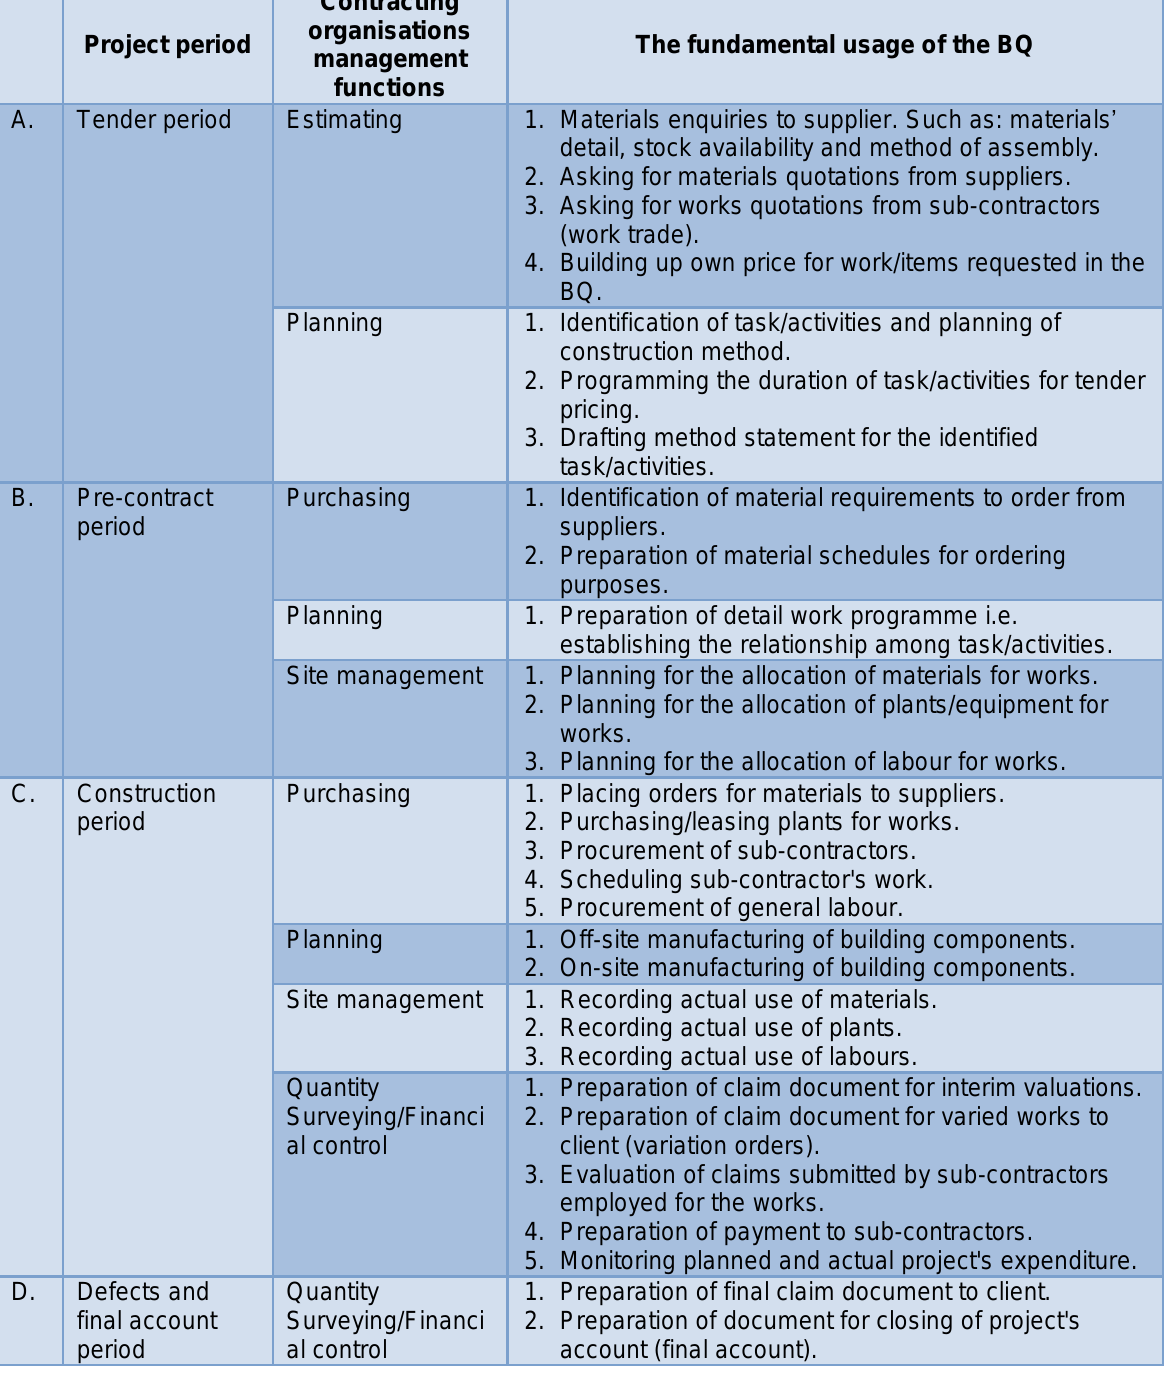
Table 6: The fundamental usage of the BQ by the contracting organisations – final outcome Source: adapted from the collation of studies by Smith and Hoong (1985, p. 20); Kodikara (1990, p. 121) and Kodikara, et al. (1993, p.